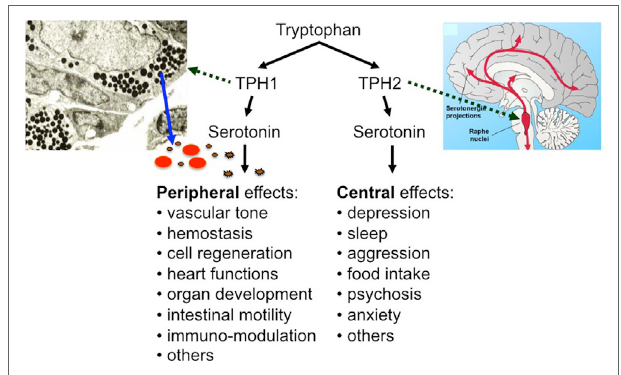
FigURe 1 | The effects of peripheral and central